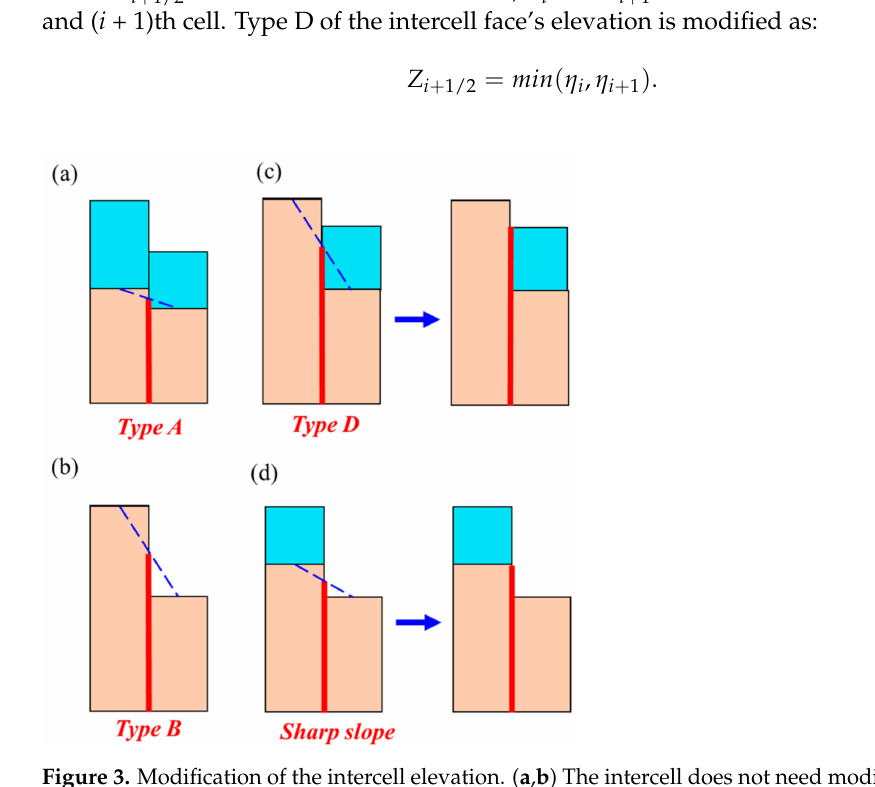
Figure 3. Modification of the intercell elevation. ( a , b ) The intercell does not need modification, which is related to Type A and Type B; ( c ) the intercell elevation is modified to the wet cell’s elevation, which is related to Type D; ( d ) the sharp slope cell is modified to the dry cell’s bed